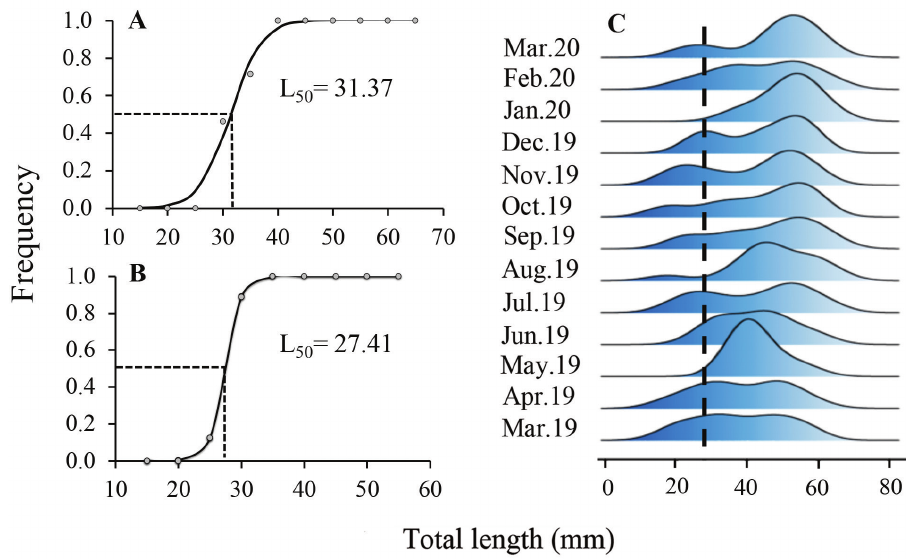
FIGURE 3 | Length at first sexual maturation ( L ) in A. Females and B. Males Helogenes marmoratus ; 50 and C. The monthly frequency histogram of the variation in total length recorded in a catchment of the Guamá River in Capitão Poço, between March 2019 and March 2020. The black dashed line indicates the lowest L , which separates adults from 50